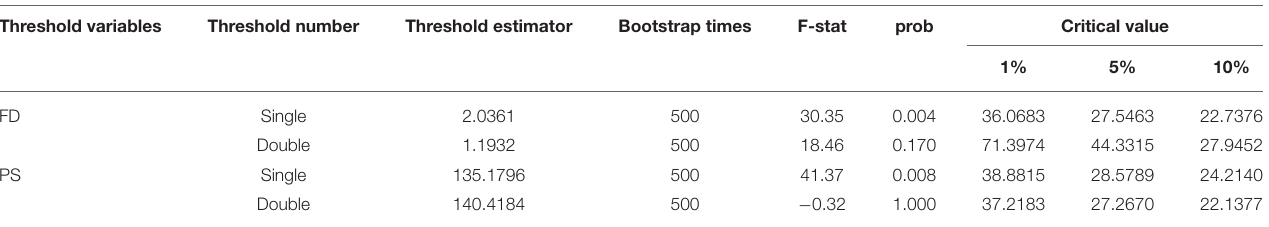
TABLE 8 | Threshold existence